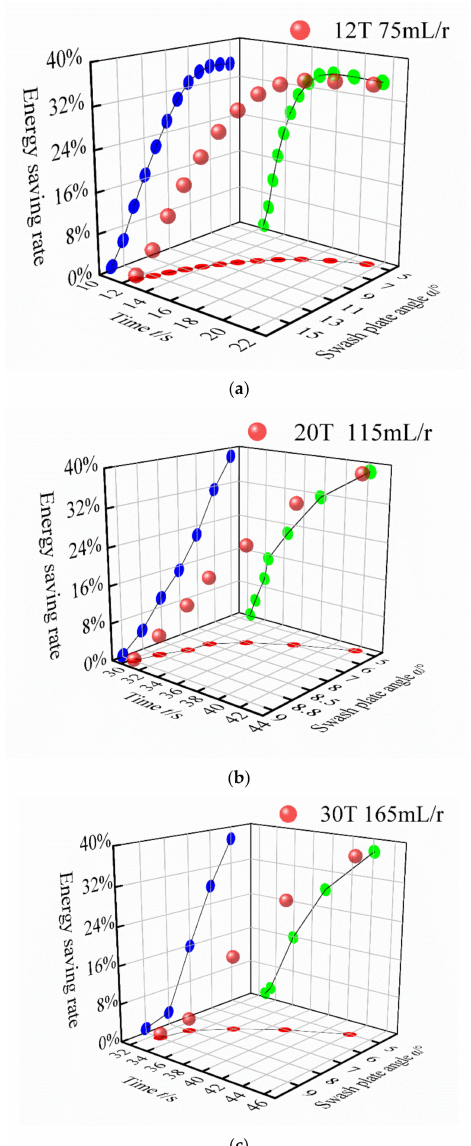
Figure 22. Displacement of VAPP and energy-saving rate required for different tons: ( a ) 12T ( b ) 20T ( c )